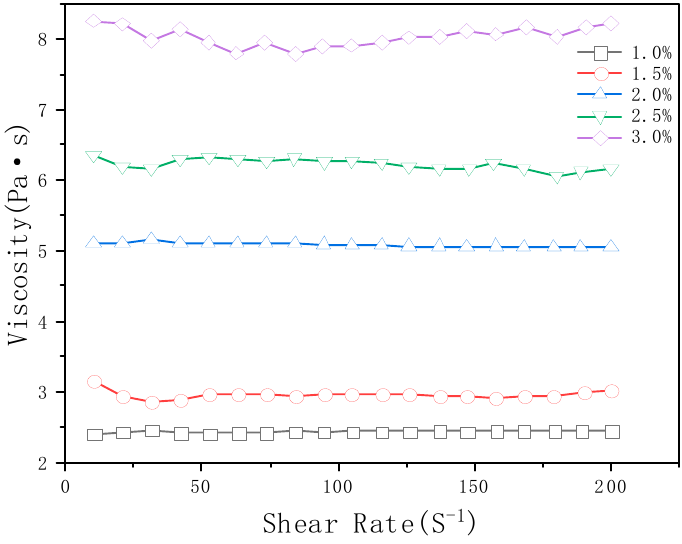
Figure 9. Effect of A-TiO 2 content on rheological properties of PU-TiO